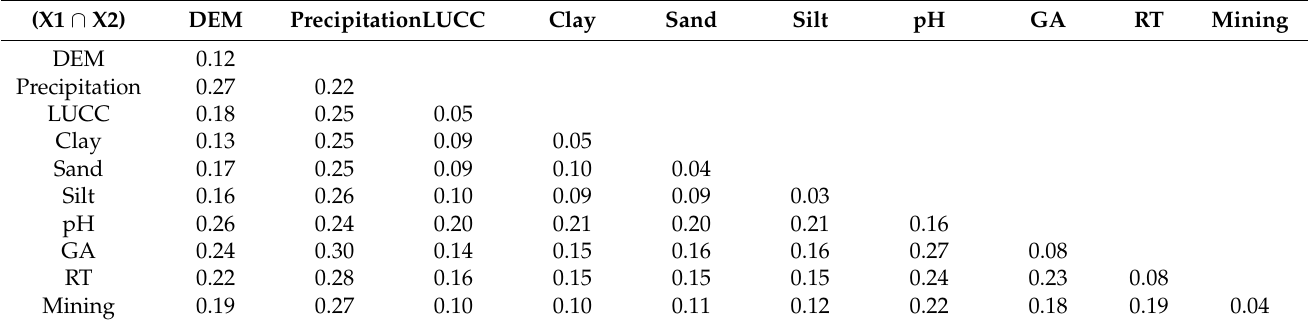
Table 4. Effects of the interaction between each pair of driving factors on the enrichment of the As concentration in the YTRB.